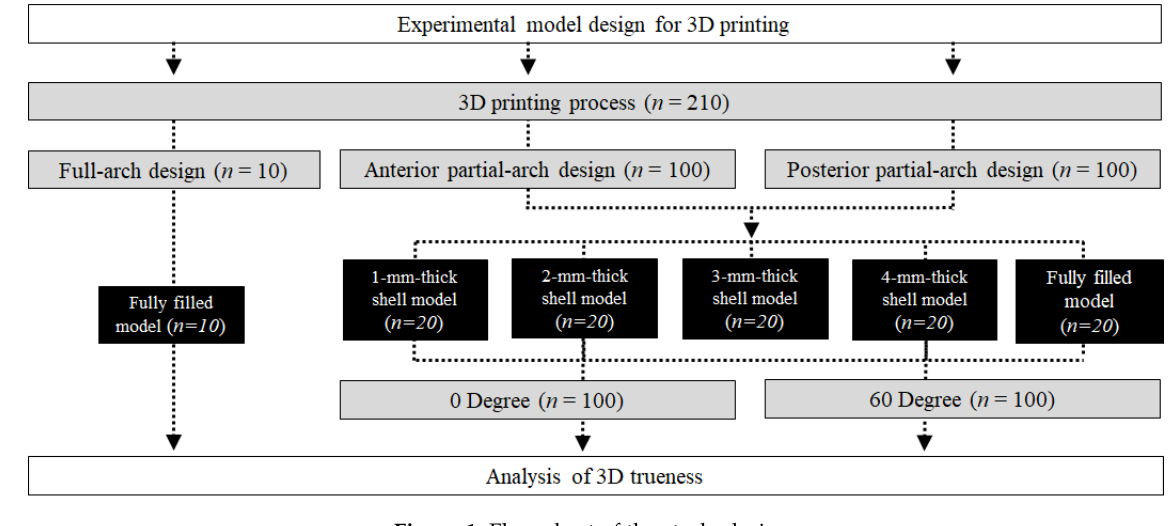
Figure 1. Flow chart of the study design.